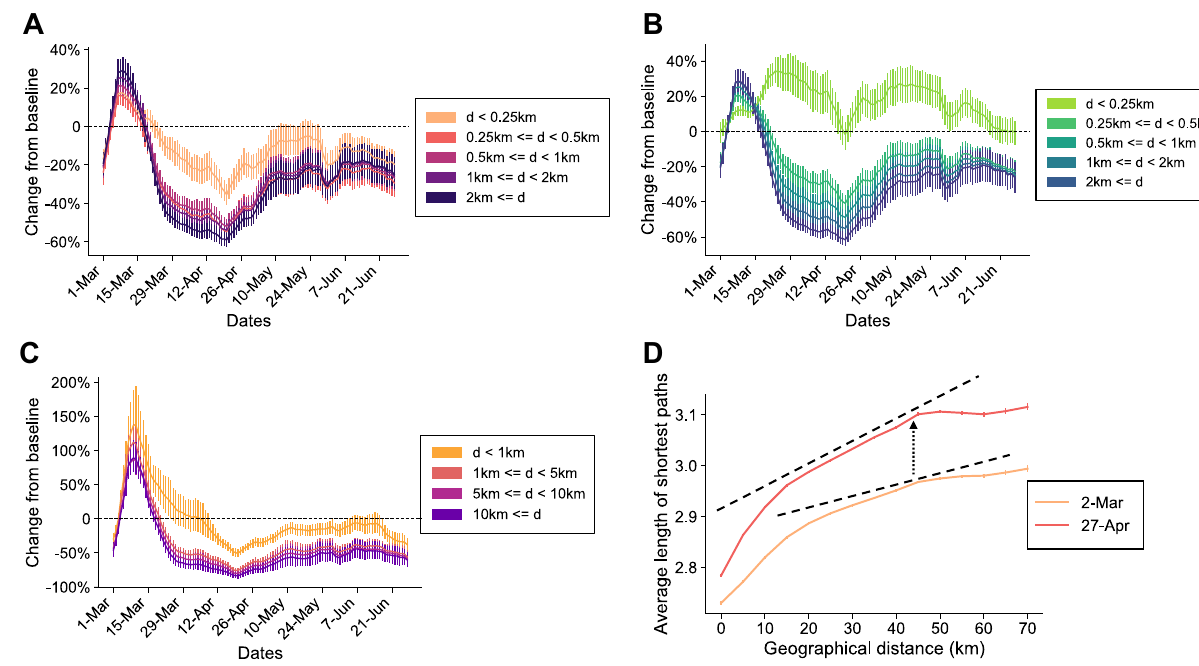
Figure 1. Empirical assessment of urban mobility changes during the COVID-19 pandemic across 21 metropolitan counties in the United States. ( A ) Relative changes in the number of trips (7-day average) based on distance categories. ( B ) Relative changes in the size of population (7-day average) based on the categories of the radius of gyration. ( C ) Relative change in number of edges based on the categories of the distance between two people’s CBGs. ( D ) Average length of shortest paths in urban mobility networks on two typical dates as a function of geographical distance between two